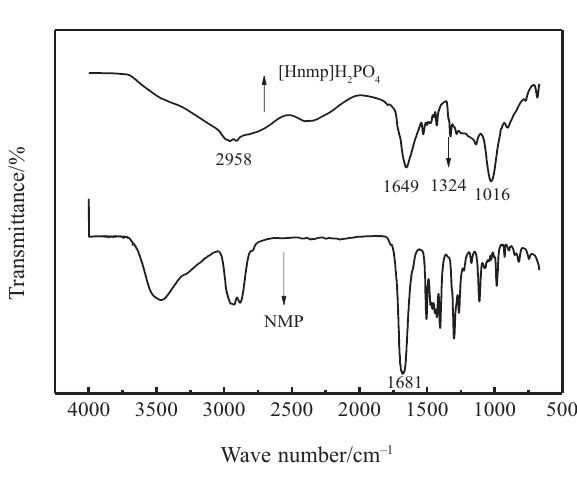
PO Fig. 3 – Investigation of the acidity of [Hnmp]H 2 4 Fig. 3 FT-IR spectroscopy